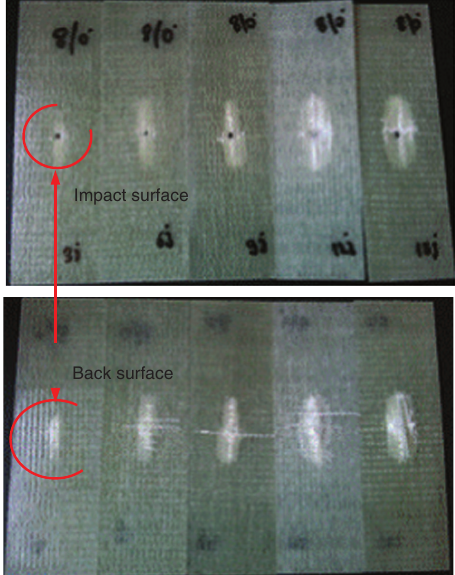
Figure 8 Damages in the impacted specimens with 8 layers.